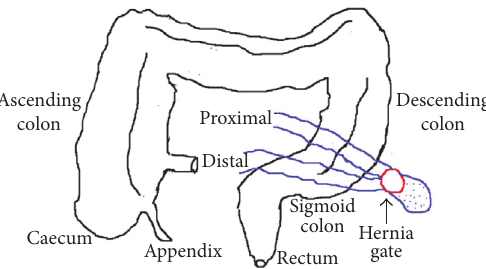
Figure 2: Schematic representation of intraoperative findings.